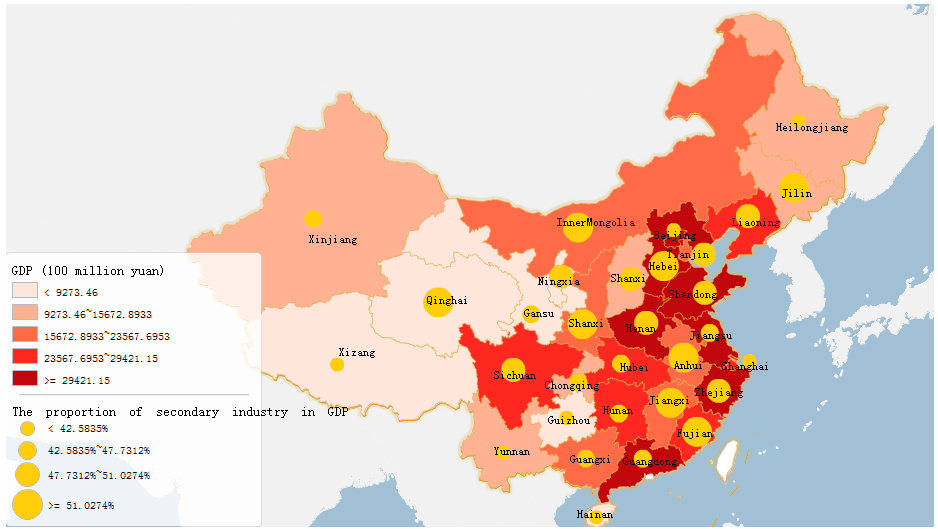
Figure 1 . GDP growth rate and the proportion of secondary industry in GDP in the provincial level of China.